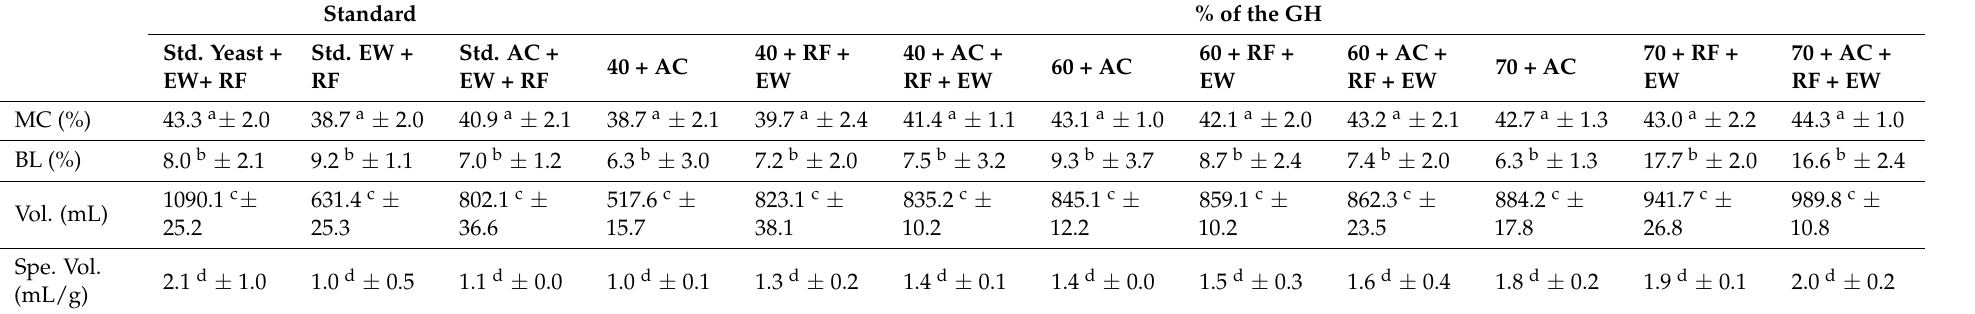
Table 1. The characteristics of GH bread with different gelling agents with reference to the